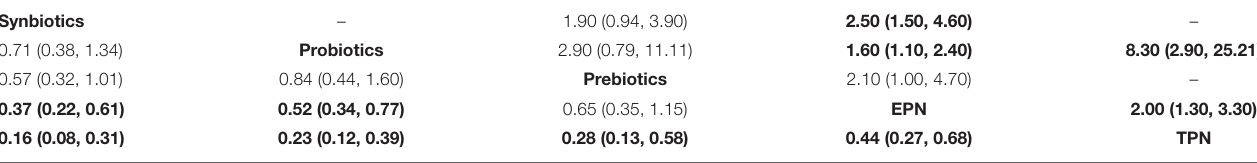
Data are the ORs (95% CrI) in the column-defining treatment compared with the row-defining treatment. With treatment as the boundary, the lower left part of the table is the result of network meta-analyses, and the upper right part of the table is the result of pairwise meta-analyses. For network meta-analyses, ORs lower than 1 favor the column-defining treatment (e.g., column 1 vs. row 4 in the lower left part of the table (synbiotics vs. EPN) is the result of network meta-analyses (OR 0.37 95% CrI 0.22–0.61), so is favor the synbiotics). For pairwise meta-analyses, ORs higher than 1 favor the row-defining treatment. (e.g., column 4 vs. row 1 in the upper right part of the table (EPN vs. synbiotics) is the result of pairwise